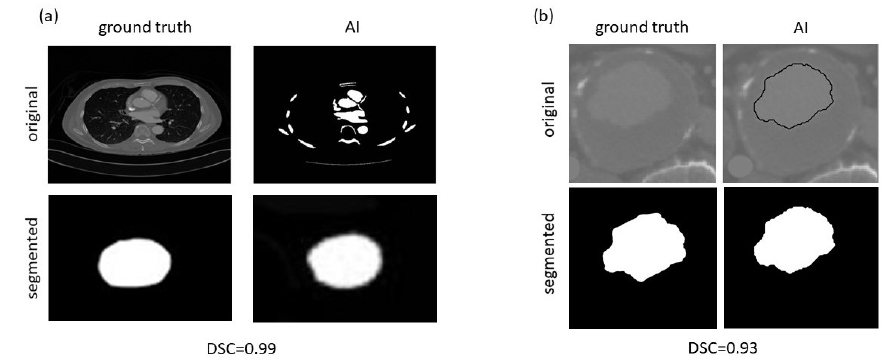
Figure 3. Image extraction for cases with the highest ( a ) and the lowest ( b )